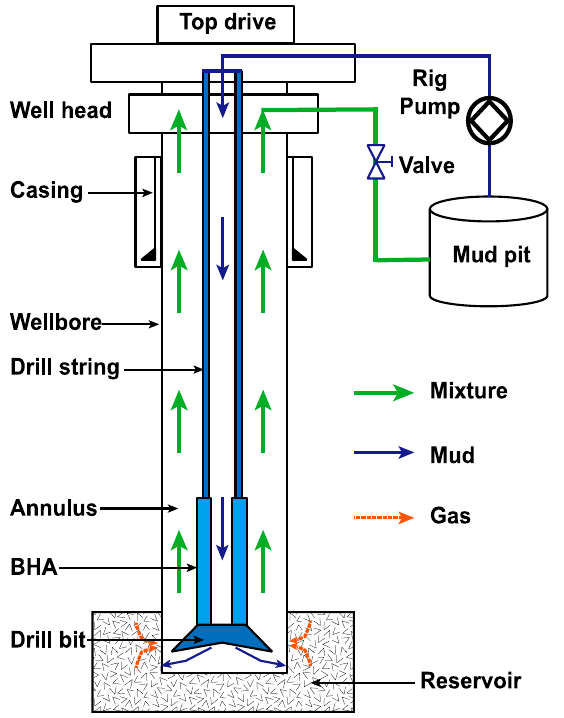
Figure 2. The typical hydraulic cycle of managed pressure drilling (MPD). BHA: bottom hole assembly.